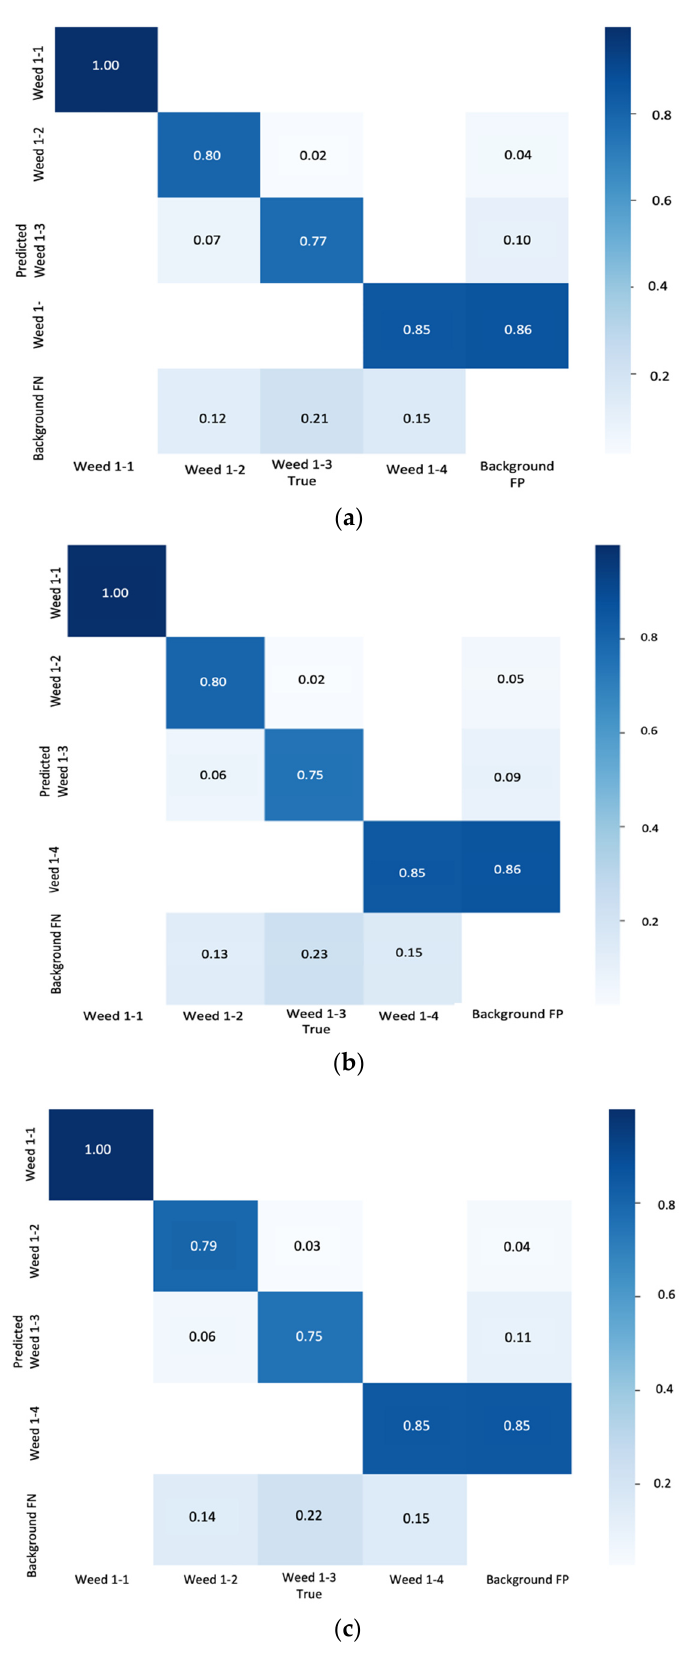
Figure 5. Confusion matrixes for YOLOv5 models: ( a ) Y L , ( b ) Y M , and ( c ) Y S .